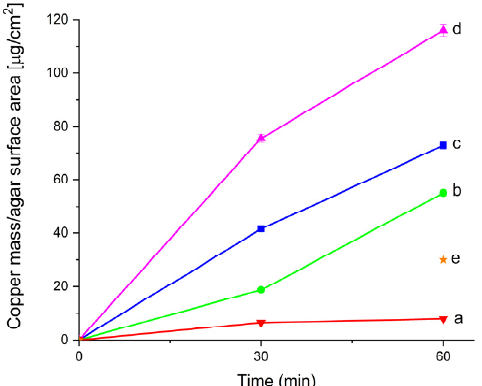
Figure 6. ICP-MS data showing the total copper content per agar surface area of pure agar gel ( a ), with TAC ( b ), with EDTA ( c ), and with ALA ( d ) after 0, 30, and 60 min of contact with laboratory stained specimens at pH 10.0. The asterisk * ( e ) reports the copper content in agar gel with EDTA and with TAC at pH 5.0 and 7.0 respectively.